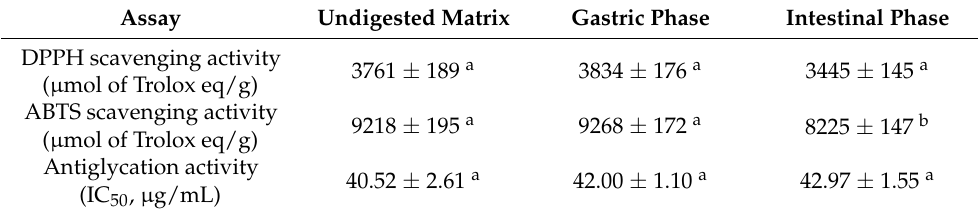
Table 1. Influence of in vitro digestion on radical scavenging and antiglycation properties of cyanidin- 3- O